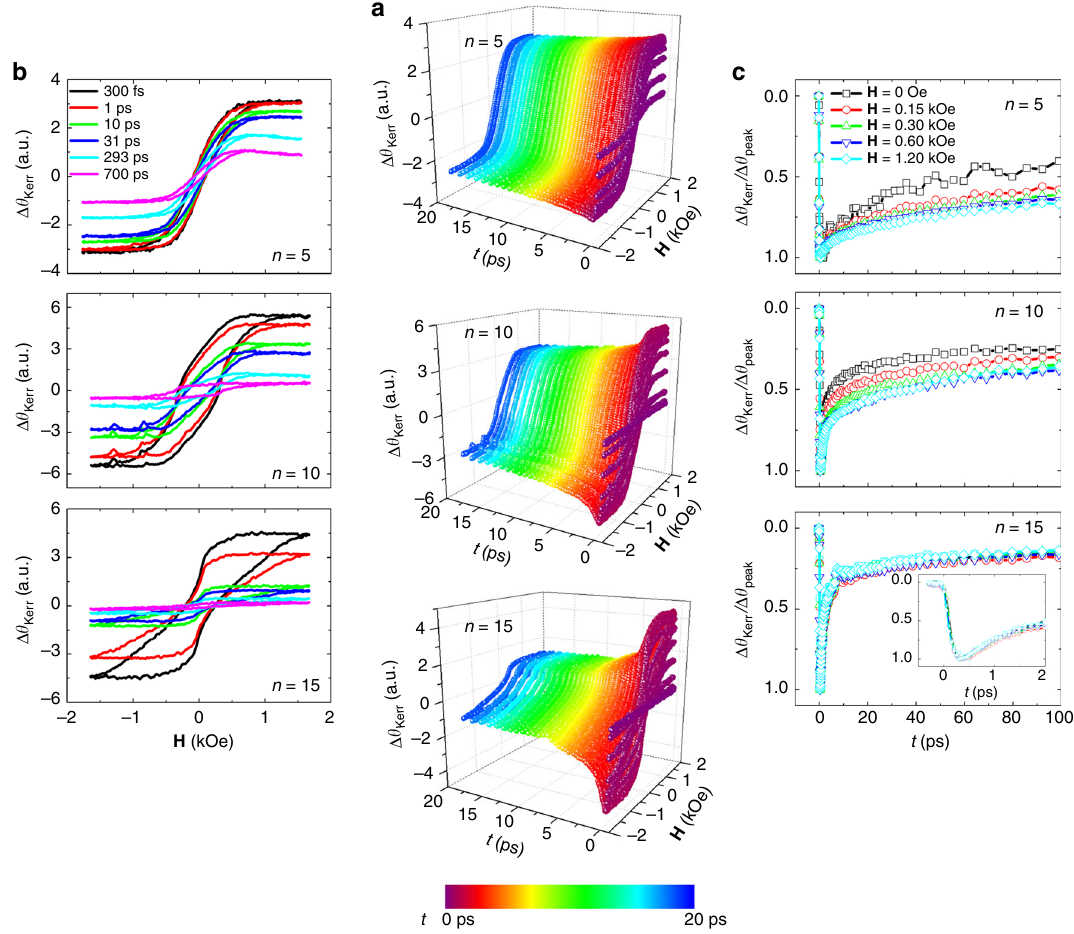
Fig. 2 Time-resolved magneto-optical Kerr effect signals. a 3D-map of TR-MOKE of [Co/Pt] n with n = 5, 10, and 15. The color code on the bottom indicates a stroboscopically elapsed time from 0 to 40 ps. b Time-dependent Δ θ Kerr hysteresis loops measured by pump-beam modulation at different delays from 300 fs to 700 ps for n = 5, 10 and 15. ( c ) Field-dependent normalized TR-MOKE signal ( Δ θ Kerr / Δ θ peak ) for n = 5, 10 and 15. The inset in the bottom shows a TR-MOKE signal within 2